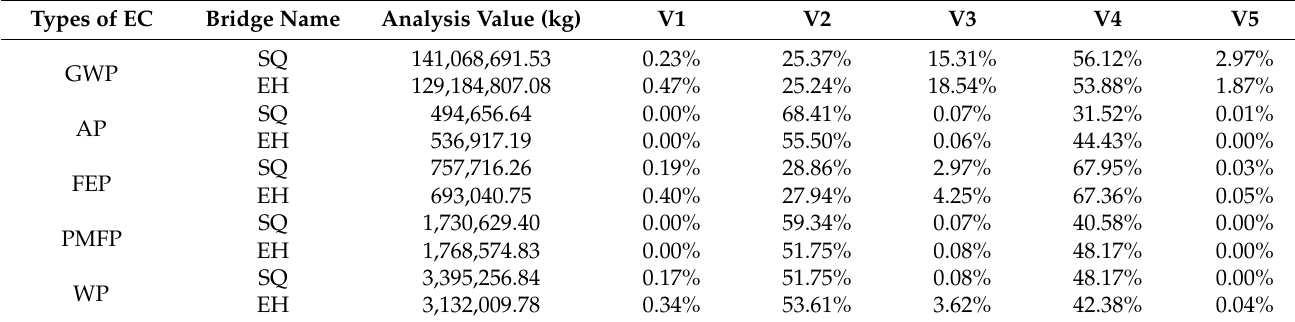
Table 6. Summary table of membership data of two cable-stayed bridge classification systems.